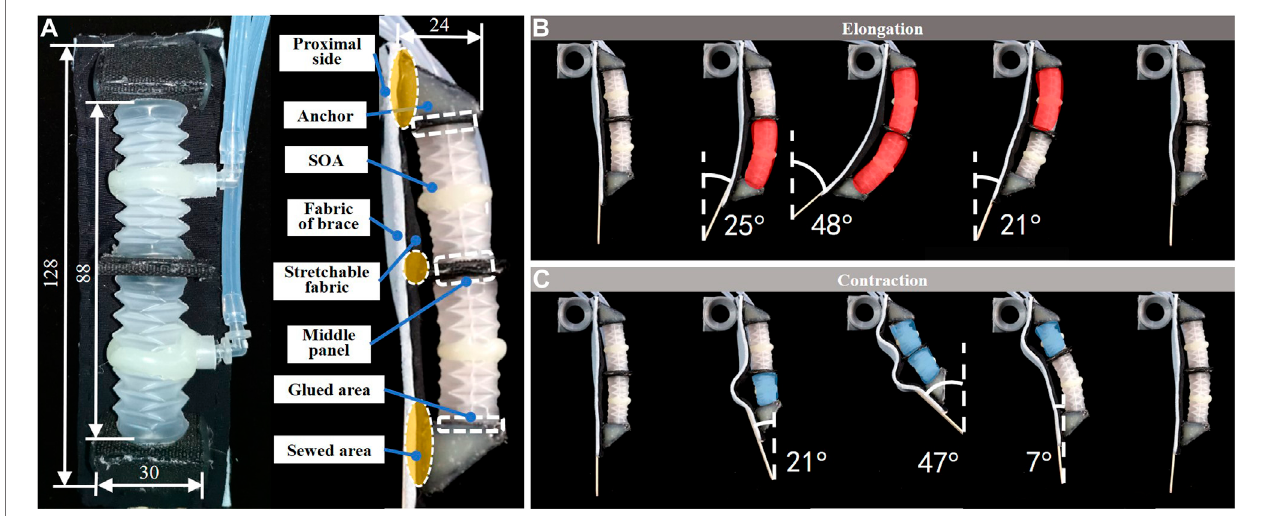
FIGURE 3 | A 2-SOA unit, (A) the unit was made of soft materials; the axial deformations of SOAs were constrained by brace fabric; (B) when pressurized, the bending angle reached 48 ° ; (C) when depressurized, the bending angle reached 47 ° .